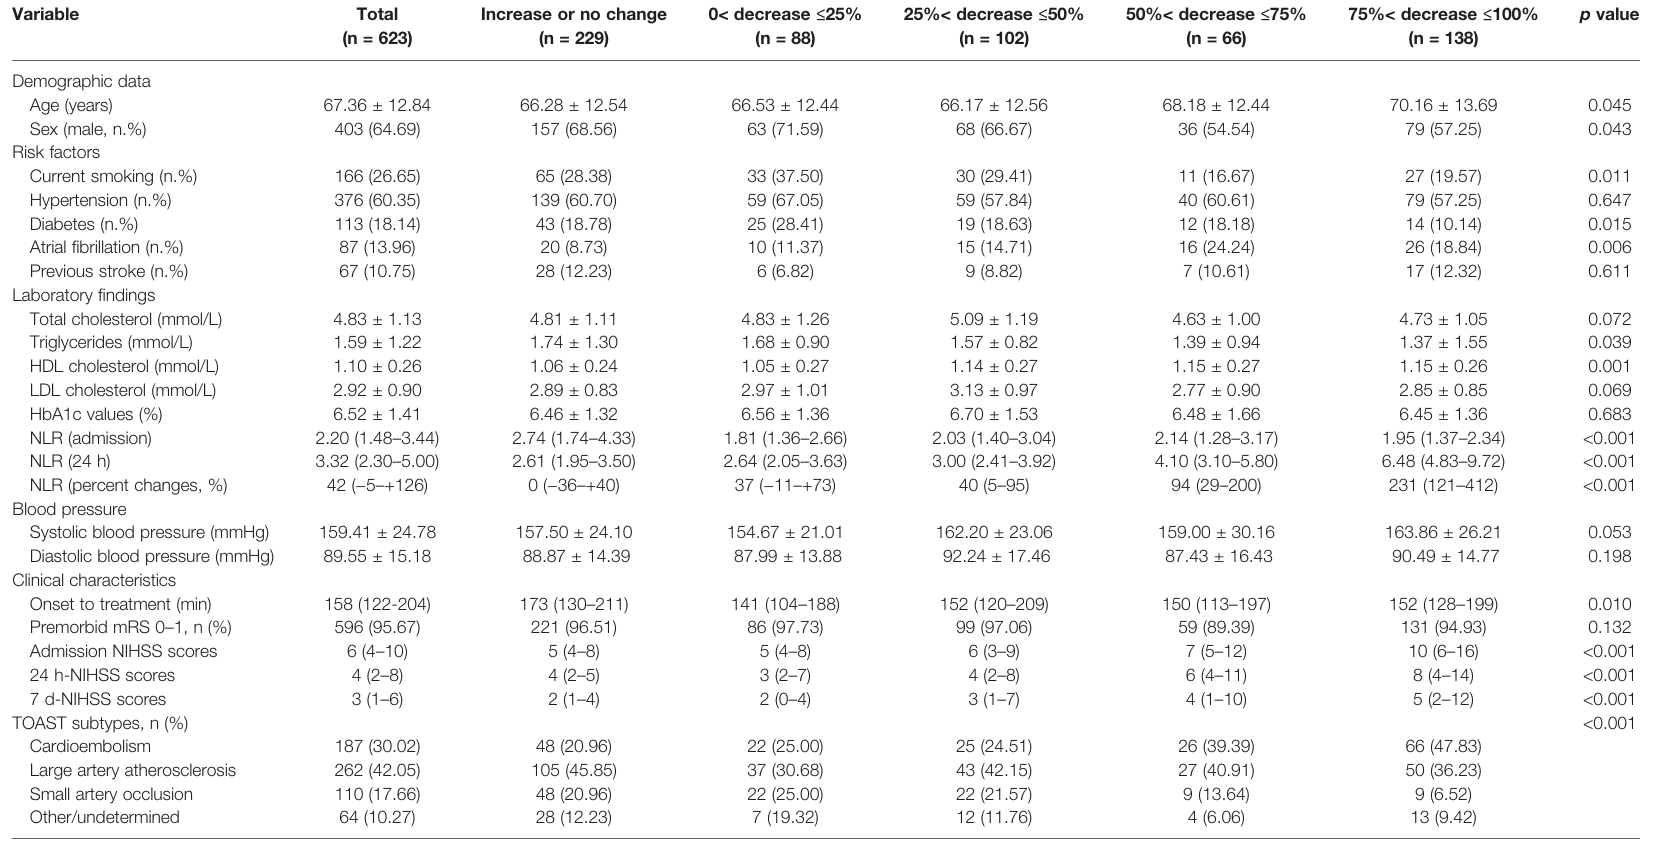
TABLE 1 | Characteristics of AIS patients According to Eosinophil Changes After Intravenous Thrombolysis.